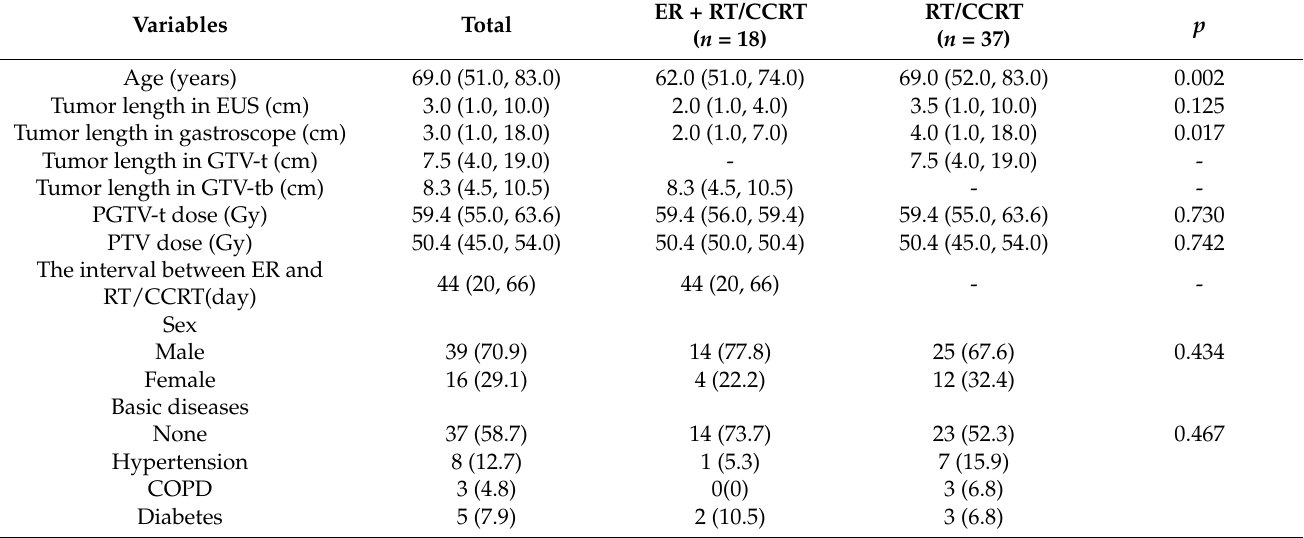
Table 1. The characteristics of patients and tumors in the two groups [M (range)/n (%)] †